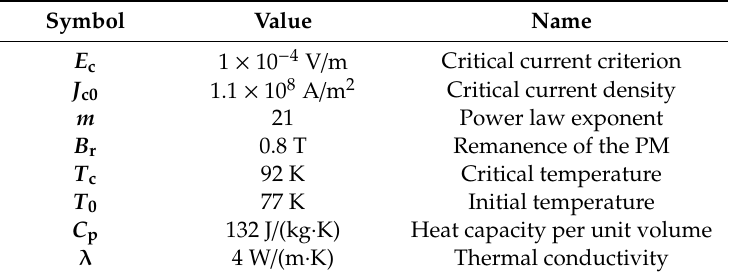
Table 1. Parameters for the